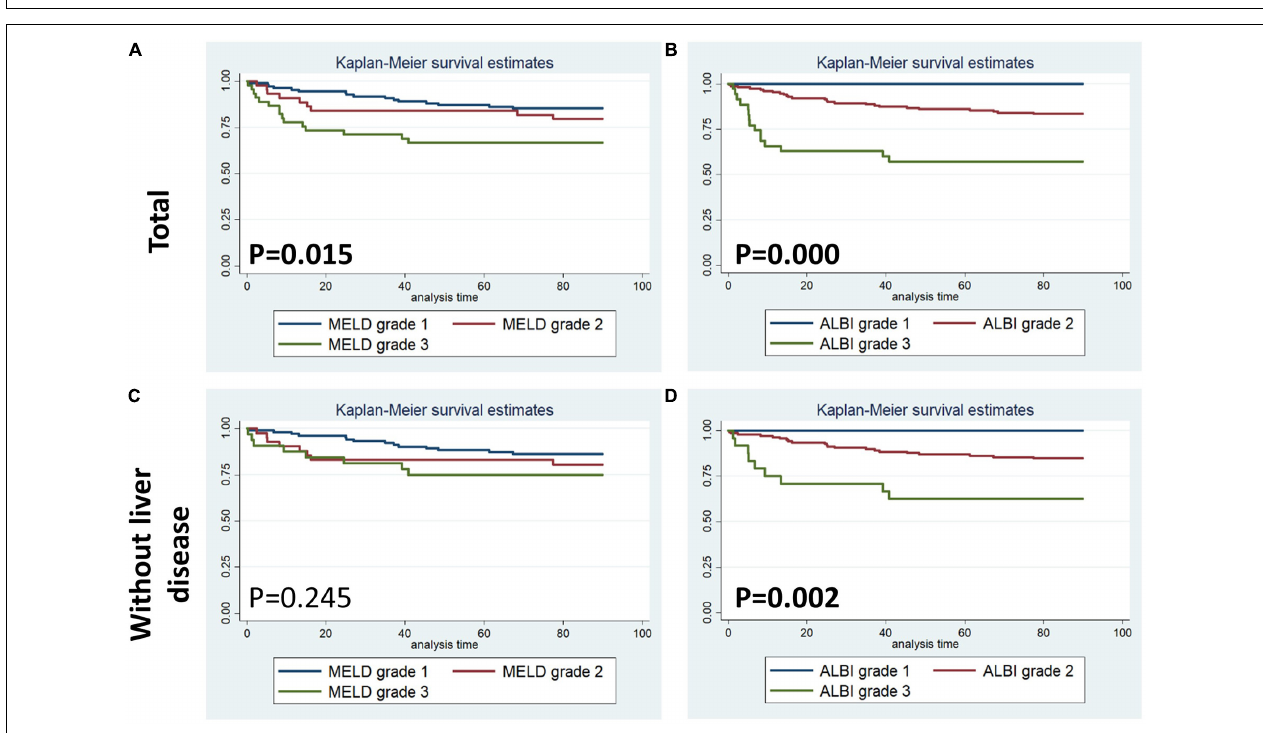
FIGURE 1 | Kaplan–Meier 90-day survival curves comparing patients by liver function index levels. Q, quartile of serum ALB, ALT, AST, and total bilirubin value; normal, clinical normal value; ALB, blood albumin; ALT, blood alanine transaminase; AST, blood aspartate transaminase. (A–D) Total patients with PPH. (E–H) Patients with PPH and without liver disease.